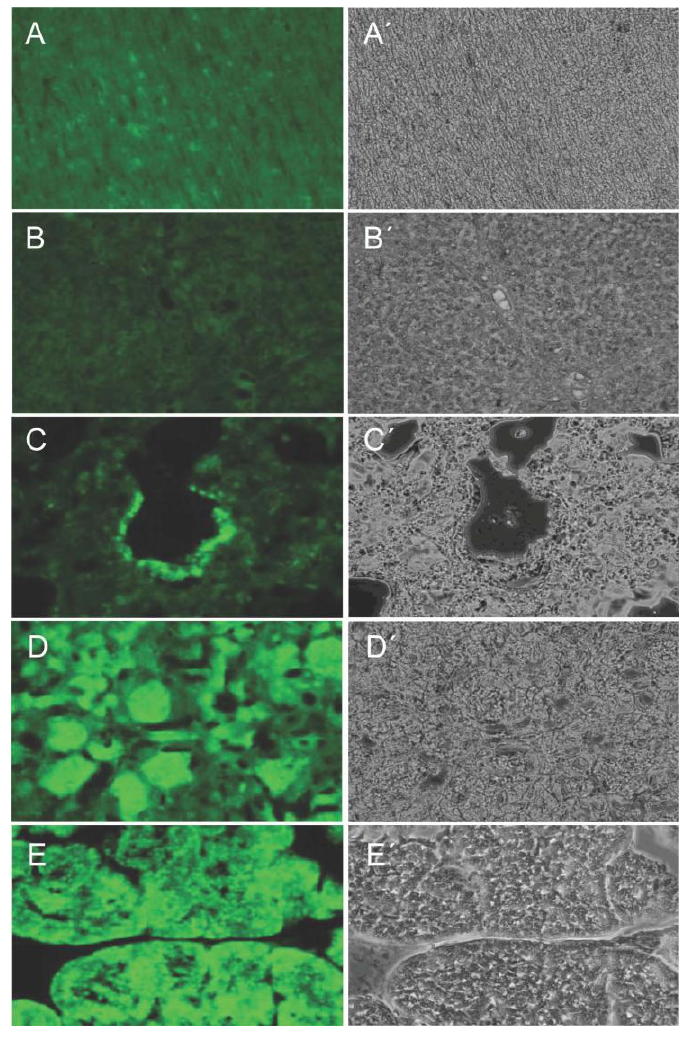
Figure 5. Organ and cell type-specific expression of Venus. Cryosections (10 µm) of A. heart, B. liver, C. lung, D. kidney, and E. pancreas of a Venus transgenic F1 pig are shown under normalized fluorescence excitation (left) and brightfield conditions (right). Almost all cells express the Venus reporter, however at cell type-specific